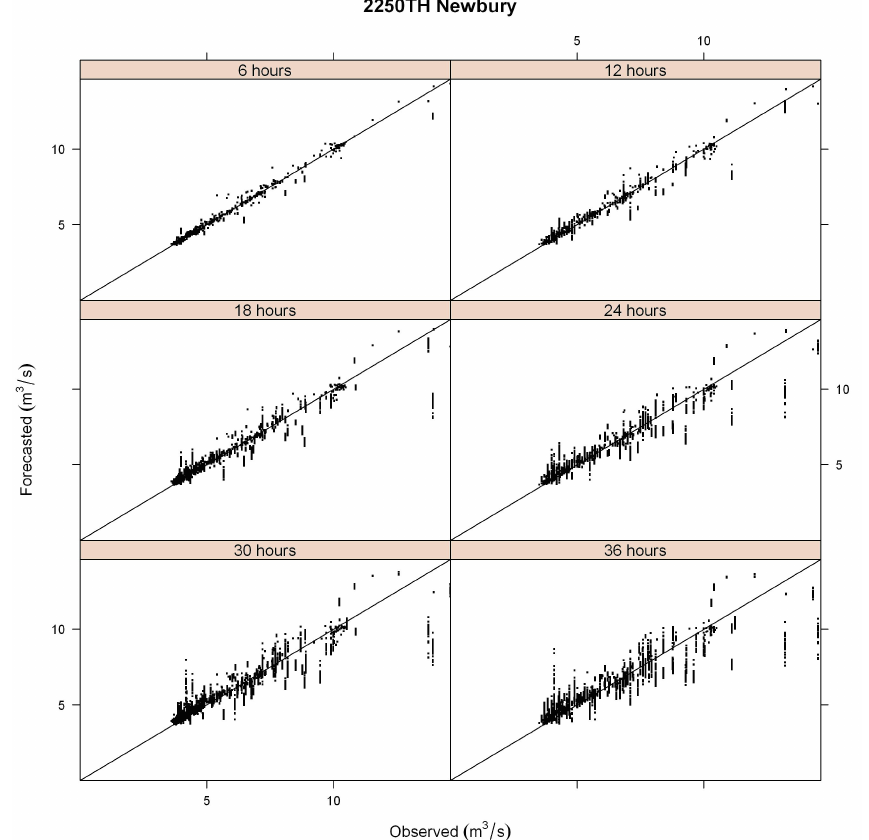
Fig. 1. Scatter plot of forecast and observed flow for different lead-times for